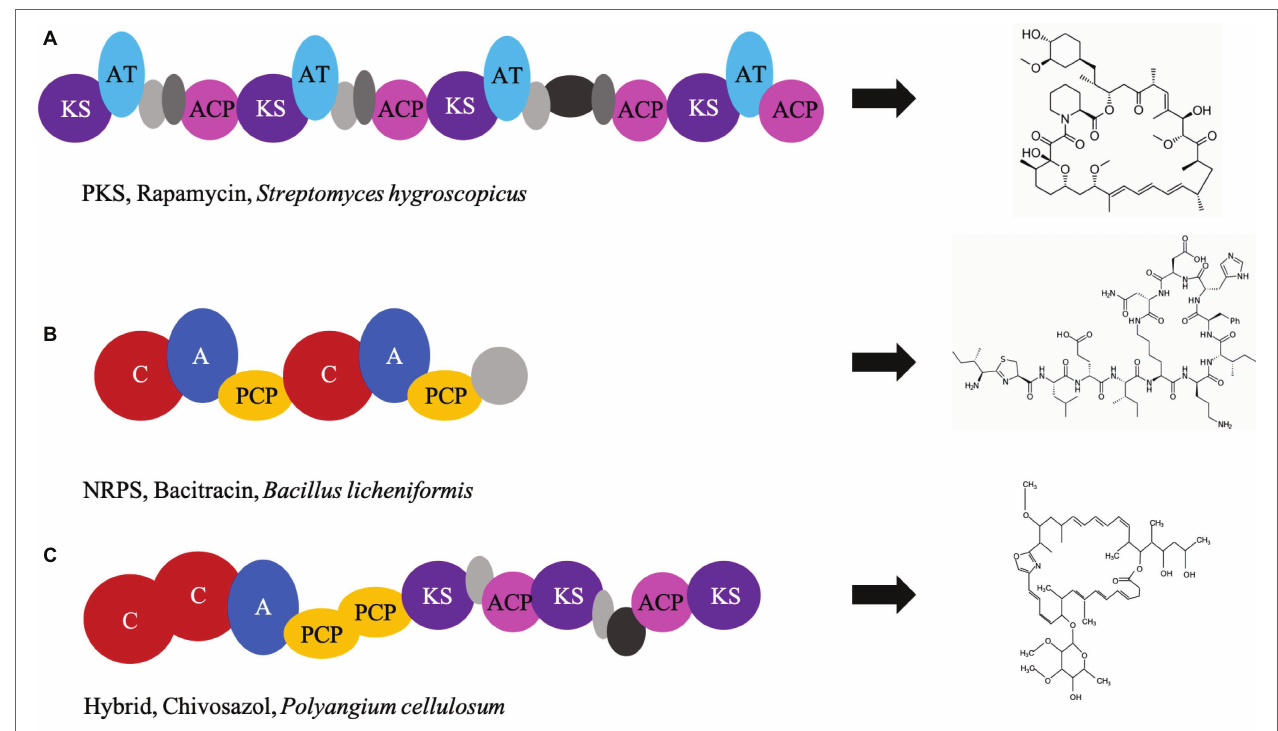
FIGURE 2 | Essential and optional domains of PKS and NRPS. The order and combination in which domains appear in the genome determines which antimicrobial compound is produced. Examples include: (A) PKS domain order that is associated with production of rapamycin (accession number X86780.1); (B) NRPS domain order that is associated with production of bacitracin (accession number EF159954); (C) domain order of PKS and NRPS that is associated with Chivosazol (accession number DQ065771). KS, ketosynthase; AT, acyltransferase; ACP, acyl carrier protein; C, condensation; A, adenylation; PCP, peptidyl carrier protein. Gray ovals depict domains that are nonessential but add variability to the antimicrobial compound. The domains were visualized from sequences using ClusterMine360 and